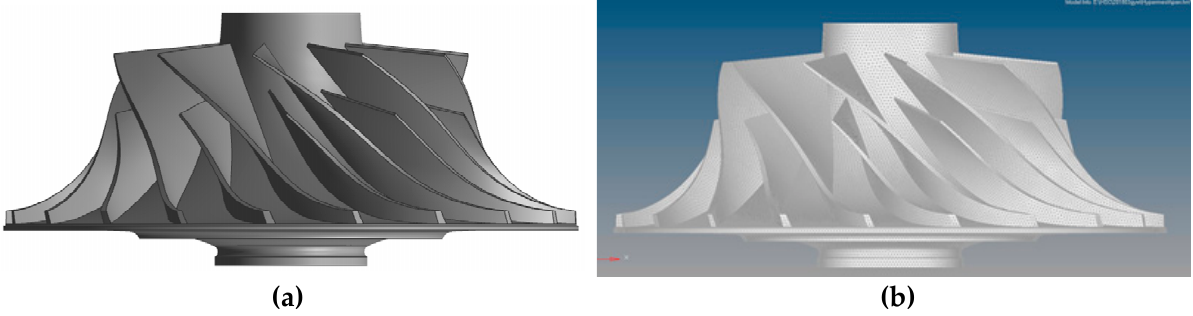
Figure 5. Geometry and finite element model of the centrifugal compressor disk: ( a ) The geometry of the centrifugal compressor disk; ( b ) The finite element mesh of the centrifugal compressor disk model.